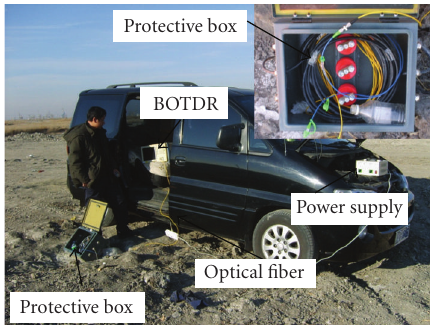
Figure 10: FRP-OF data acquisition.